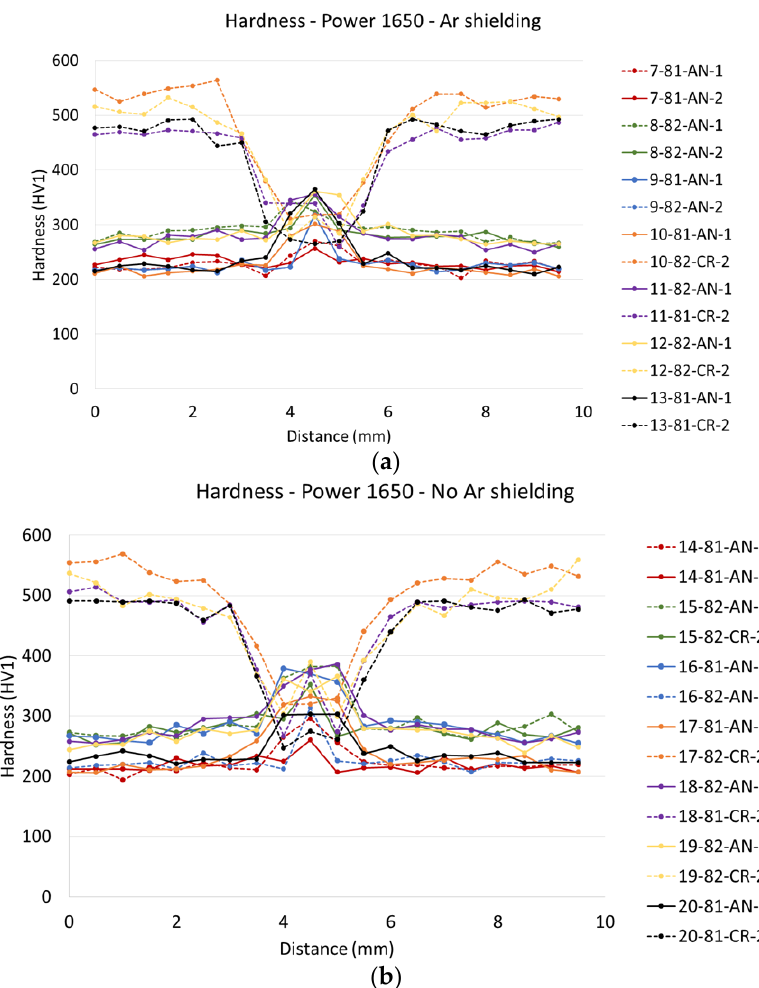
Figure 10. Hardness of weld joints vs. the use of shielding gas: ( a ) Joints made by gas-shielded welding; and, ( b ) Weld joints made without shielding gas.